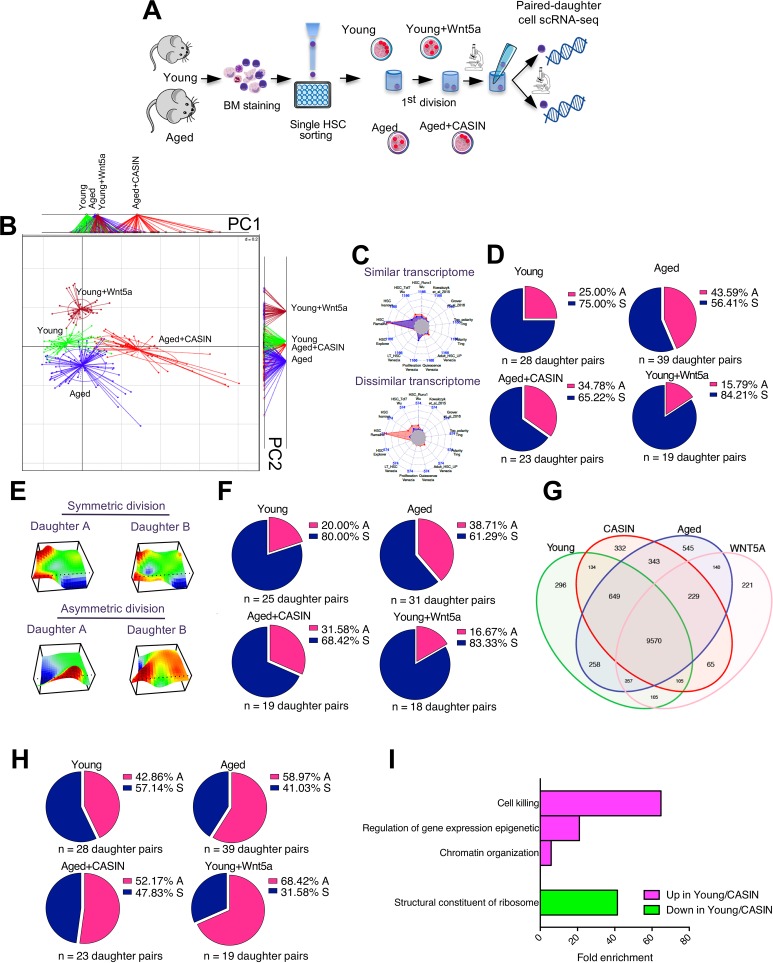
The transcriptome does not reflect the potential of daughter cells.(A) Schematic representation of the experimental setup for the preparation of scRNA-seq libraries of daughters pairs from young, aged, aged treated with CASIN, and young treated with Wnt5a HSCs (graphical sources: https://www.servier.de/medical-art and https://openclipart.org/) (B) Correspondence based on BGA of the global expression profile of single daughter cell pairs after division. In total, 25–28 pairs for young, 31–39 pairs for aged, 19–23 pairs for aged CASIN-treated, and 18–18 pairs for young Wnt5a treated HSCs; n = 3–5 biological repeats. (C) Representative radar plots of the GSEA showing 1 similar and 1 dissimilar daughter pair. The analysis approach simultaneously interrogated 13 previously published HSC and polarity signatures, and each daughter cell pair was depicted in a radar plot where vertices in the plot correspond to each of the considered gene set. Pairs were then compared for significance of similarity/dissimilarity by a goodness of fit test across all significant gene sets. (D) Pie charts depicting the percentage of asymmetric and symmetric divisions of young, aged, aged treated with CASIN, and young treated with Wnt5a daughter cell pairs based on the GSEA. (E) Representative 3D-SOM analysis of the whole scRNA-seq transcriptome of 1 concordant and 1 discordant daughter pair. (F) Pie charts depicting the percentage of asymmetric and symmetric divisions of young, aged, aged treated with CASIN, and young treated with Wnt5a daughter cell pairs based on the 3D-SOM metagene analysis. To quantify the degree of similarity between SOMs of daughter pairs, we identified genes that showed statistically significant log fold change compared to the mean global expression profile (namely metagenes, corresponding to the hills and valleys in the 3D plots shown in panel E). This information was then used to compare daughter pairs and identify concordant genes, i.e., genes that show same direction of change. Eventually, we compared the ratio of concordant genes to the discordant ones and calculated a QCR. Each pair was then identified as concordant or discordant based on the magnitude and direction of the QCR value (tested for significance using Monte-Carlo simulation). (G) Venn diagram showing differential gene expression analysis for up-regulated genes. (H) Pie charts depicting the percentage of asymmetric and symmetric divisions of young, aged, aged treated with CASIN, and young treated with Wnt5a daughter cell pairs based on the 134 genes up-regulated in the daughter cells from young and aged CASIN-treated arms but not in the aged HSCs and young Wnt5a-treated ones. (I) Bar graph showing fold enrichment for biological processes in the 134 up-regulated genes in young and aged CASIN-treated daughter pairs but not in the aged HSCs and young Wnt5a-treated ones, and in the 6 genes down-regulated in young and aged CASIN-treated daughter pairs but not in the aged HSCs and young Wnt5a-treated ones. GO analyses for biological processes were done with Panther version 11.0. The primary data the figure is based on are provided in GEO GSE116712. BGA, between-group analysis; CASIN, cdc42 activity specific inhibitor; cdc42, cell division control protein 42; GO, gene ontology; GSEA, gene set enrichment analysis; HSC, hematopoietic stem cell; QCR, Quadrant Count Ratio; scRNA-seq, single-cell RNA sequencing; SOM, self-organizing maps.